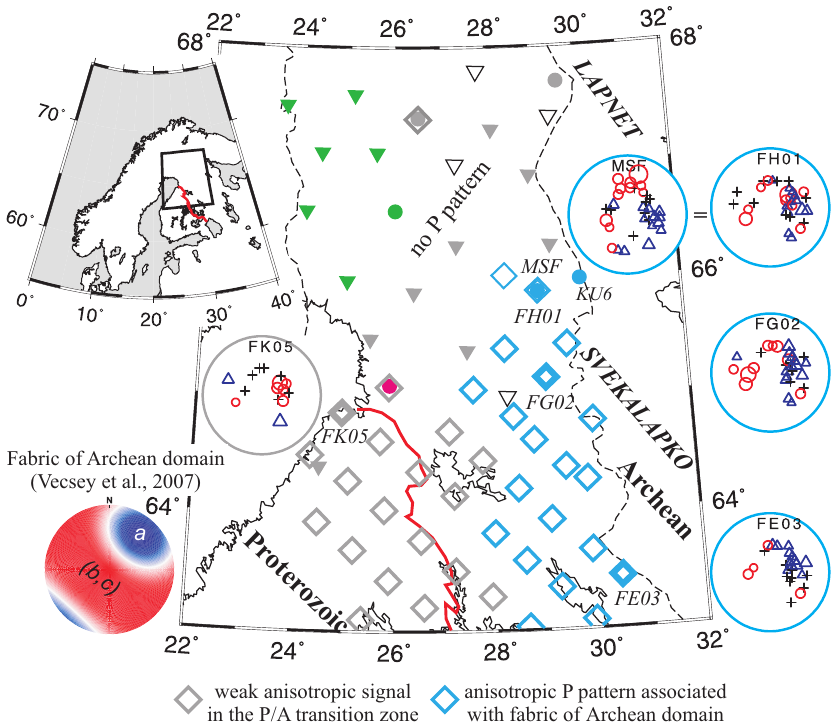
Fig. 6. Linkage of the P-sphere patterns in the southern part of the LAPNET array overlapping with the northern part of the SVEKALAPKO array. No P-pattern identified in the south-eastern part of the LAPNET array (full grey triangles and circles) concurs with the weak anisotropic signal at stations above the Proterozoic/Archean (P/A) transition zone in the upper mantle evaluated from the SVEKALAPKO data (Plom- erov´a et al., 2006). Examples of the P-spheres for stations FH01, FG02 and FG03 of the SVEKALAPKO array in the Archean domain of Karelia (blue diamonds) show high degree of resemblance with the two south-easternmost stations of LAPNET (MSF and